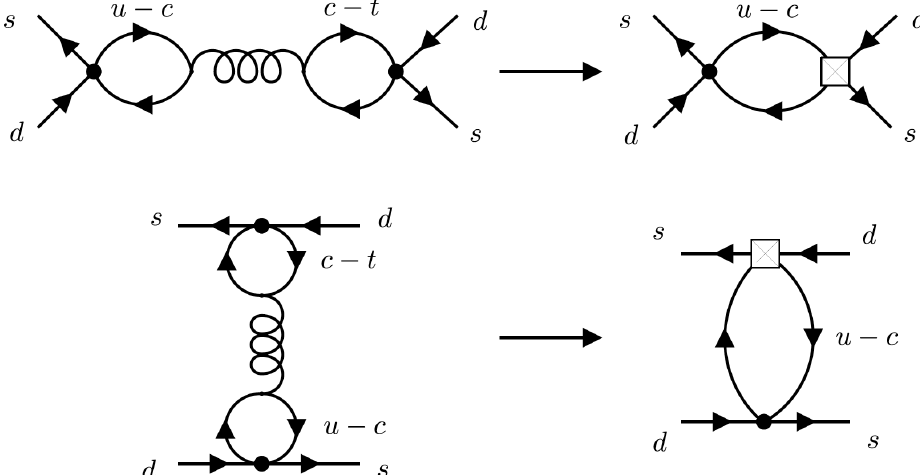
Figure 2 . On the left side the K 0 − ¯ K 0 double penguin diagrams, on the right side their reinter- pretation in terms of connected diagrams. The box represents the insertion of the penguin operator defined in eq.